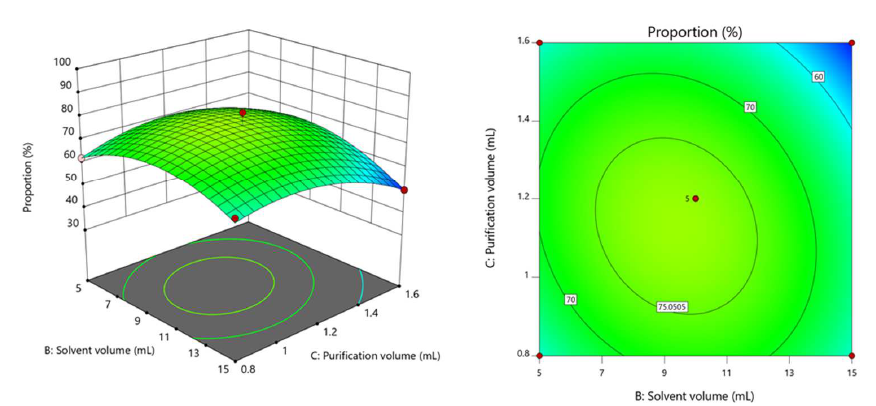
Figure 6. Response surface and contour diagram of R = f (B, C) with a 2 mL water volume.